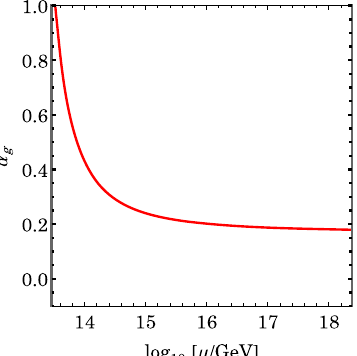
Fig. 1 Renormalization evolution of the axicolor coupling α g from the fermion dynamical mass scale m F up to the Planck scale M pl (cid:4) 2 . 4 × 10 18 GeV in the strong coupling regime, in the anti-Veneziano limit ( N F , N C (cid:2) 1 with N F / N C (cid:2) 1). As a reference, the numbers of axicolors N C and axicolored fermions N F are taken as ( N C , N F ) = ( 5 , 45 ) , inspired by Eq. (6), and we have chosen m = 2 . 9 × 10 13 F GeV as in the text. At the scale m F the dimensional transmutation takes place following the nonperturbative beta function β NP g in Eq. (7), or equivalently the Miransky scaling in Eq. (5), and the scalar potential is expected to be stabilized all the way above this